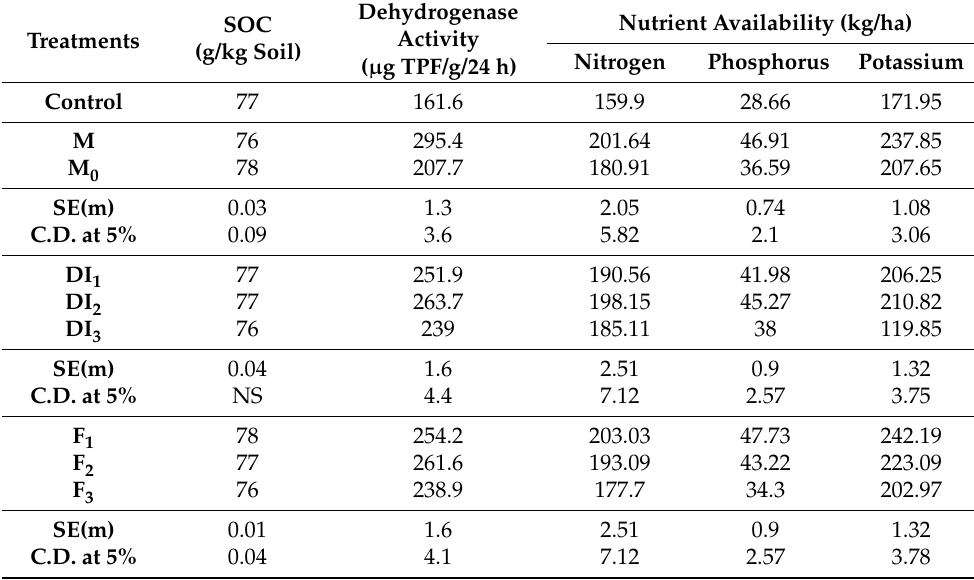
Table 3. Effect of plastic mulch, drip irrigation, and fertigation system on the rhizospheric soil carbon content, enzyme activity, and nutrient availability under the